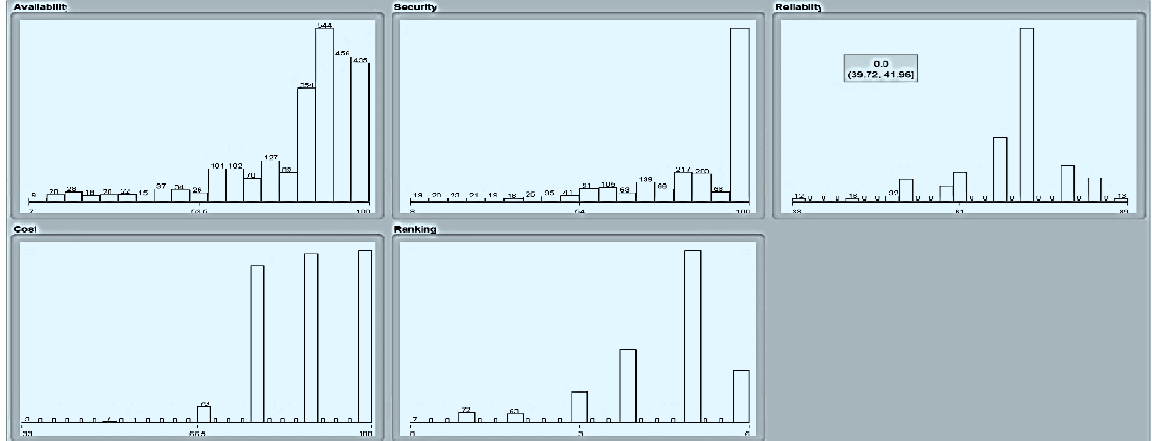
Figure 8. Parametric distribution of dataset.